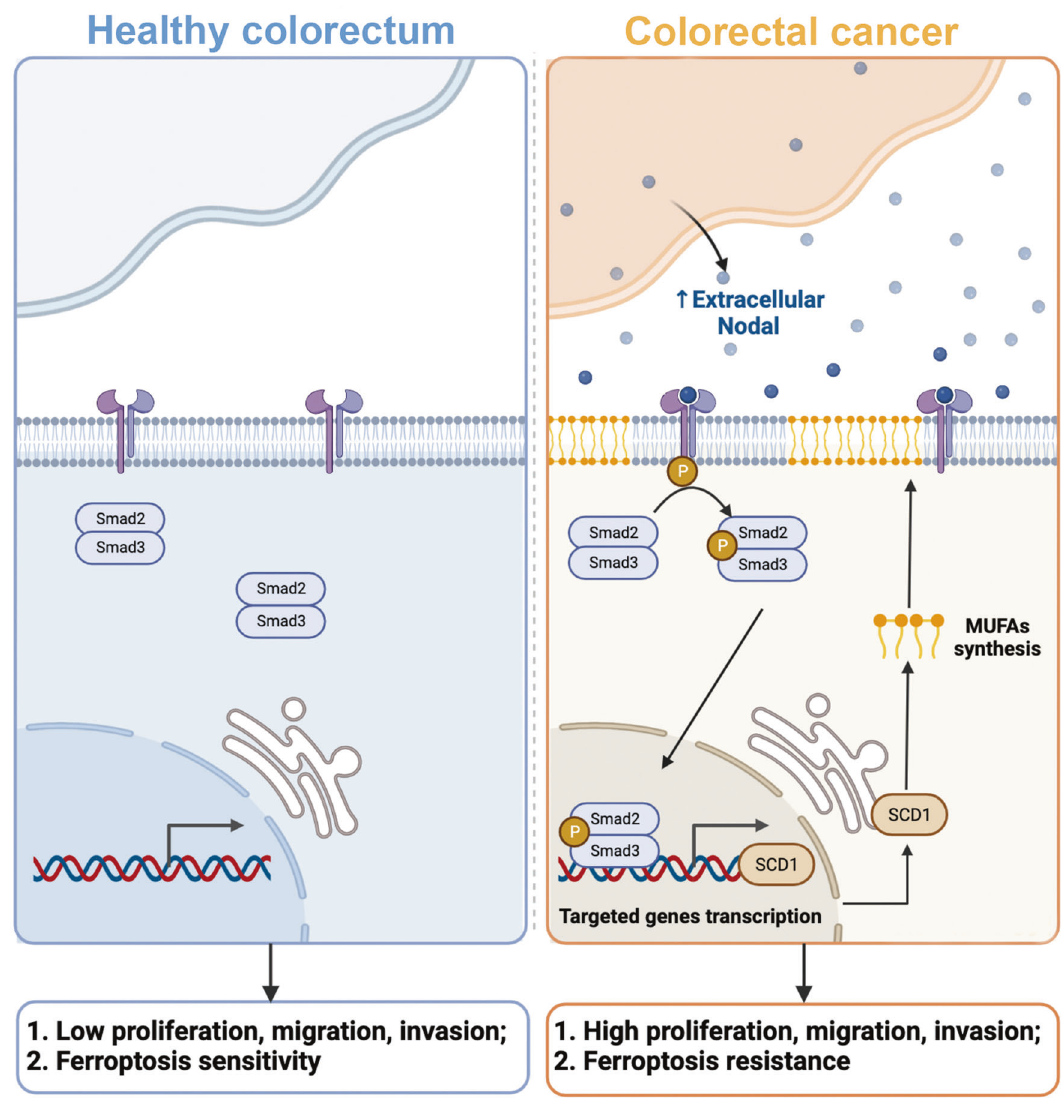
Fig. 8 Mechanism of CRC pathogenesis. In the CRC microenvironment, Nodal is abundantly overexpressed and secreted by CRC cells, which subsequently activates the Smad2/3 signalling pathway. Activation of the Smad2/3 signalling pathway increases the expression of SCD1 at the transcriptional level, thereby increasing fatty acid desaturation. This contributes to the resistance of tumour cells to ferroptosis and promotes cell proliferation, migration, and